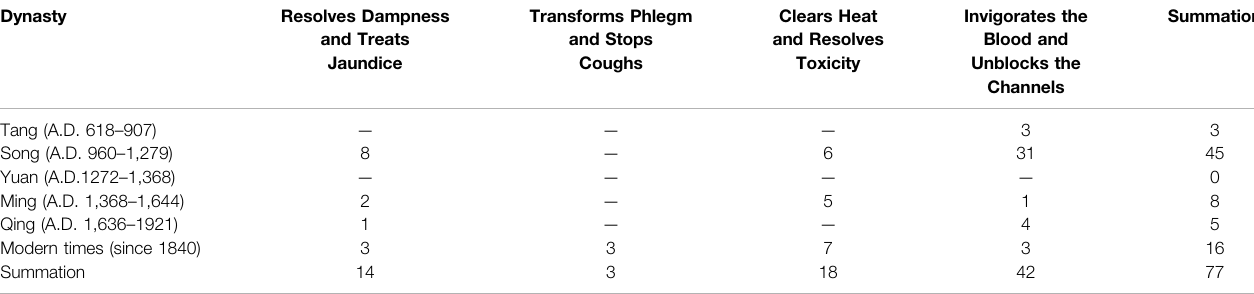
TABLE 1 | Utilization of various functions of HZ in different historical periods.